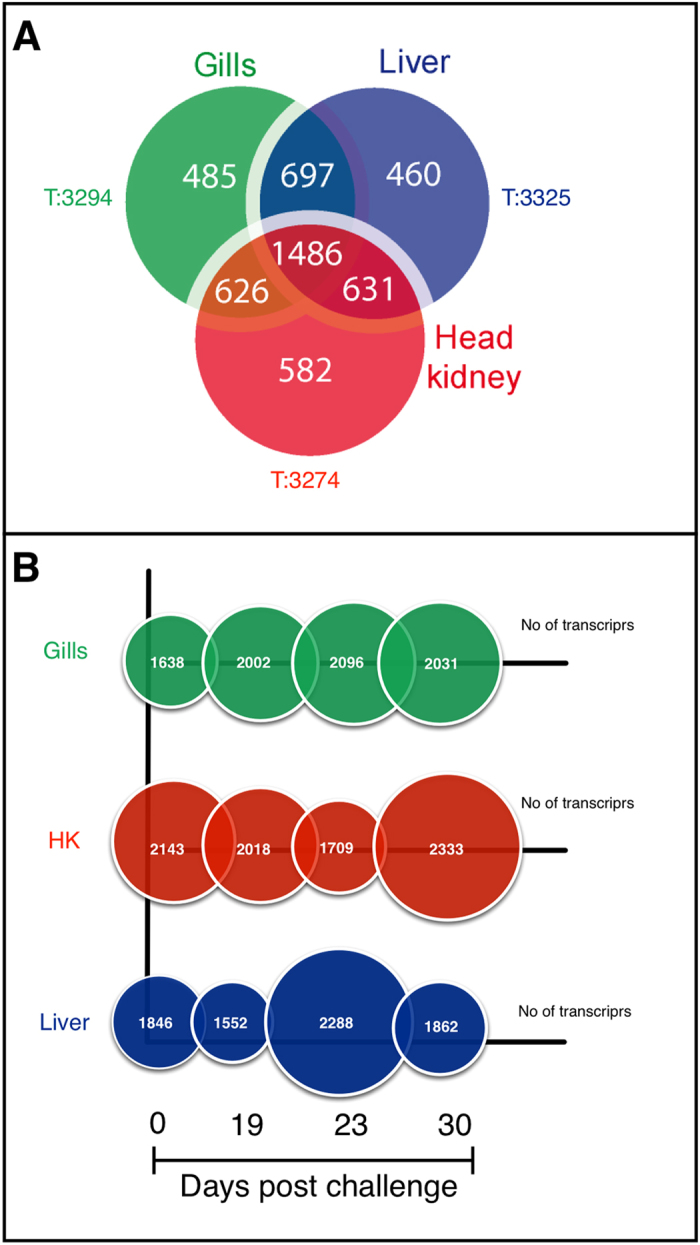
Tissue-wide distribution of lnRNAs.Distribution of 5,636 novel lnRNAs across three tissues. (A) Venn diagram representing the differentially expressed lncRNAs distributed between the gills (Green), liver (Blue), and head-kidney (Red). (B) Distribution of lncRNAs across the different sampling time points.